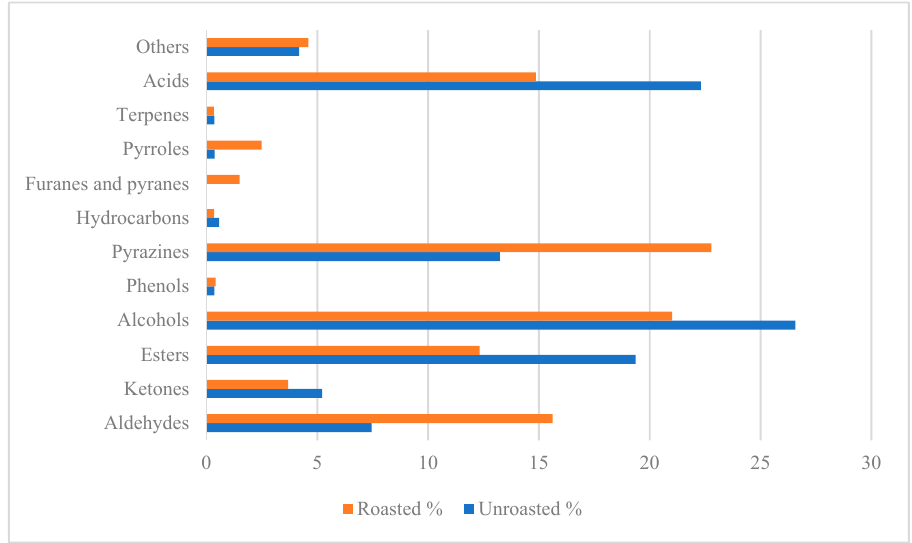
Figure 1. Relative percentage of volatile compounds before and after roasting. Source: taken and adapted from [22].